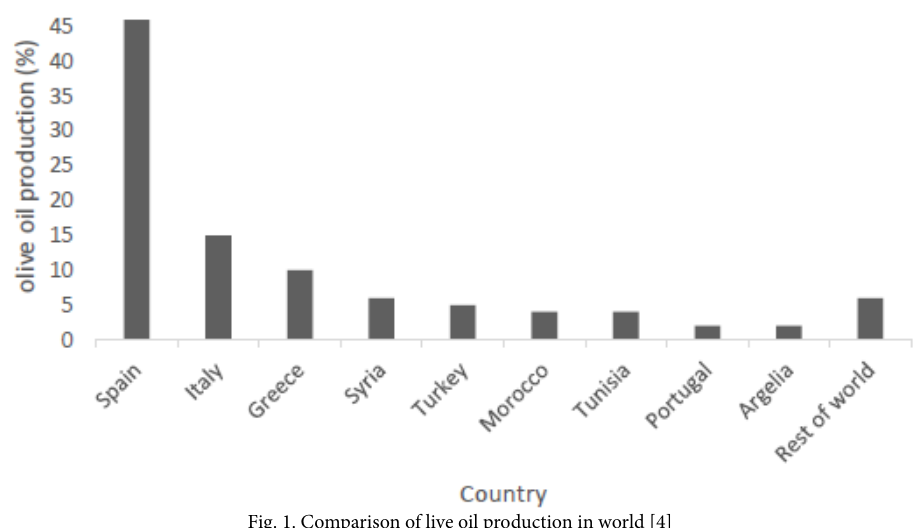
Fig. 1. Comparison of live oil production in world